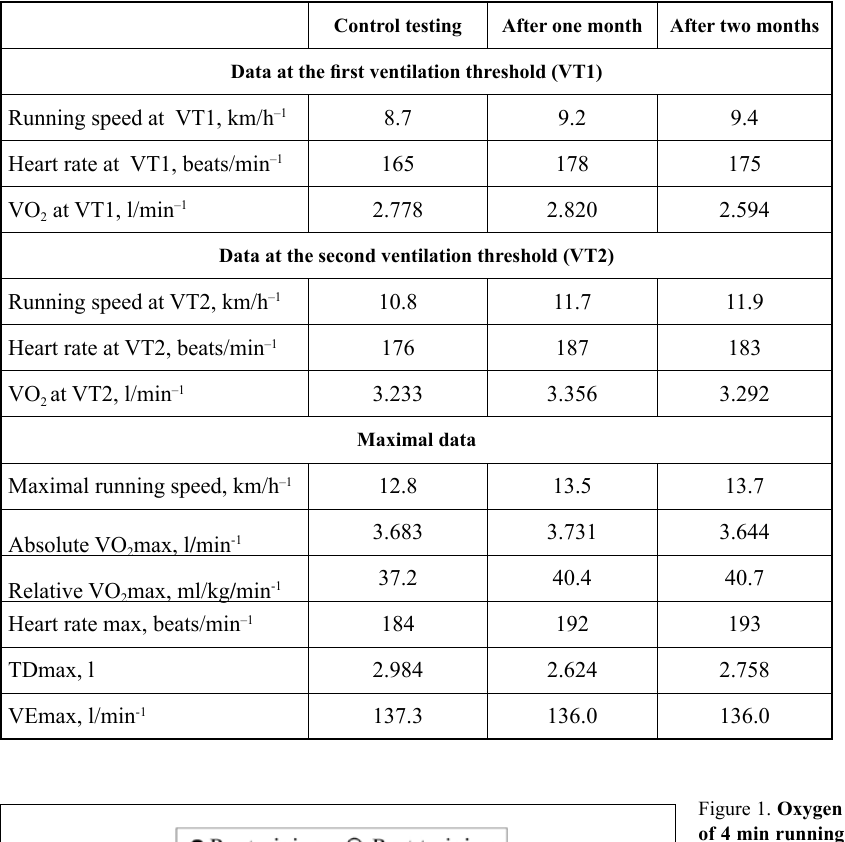
Table 2. Aerobic capacity para- meters during incremental